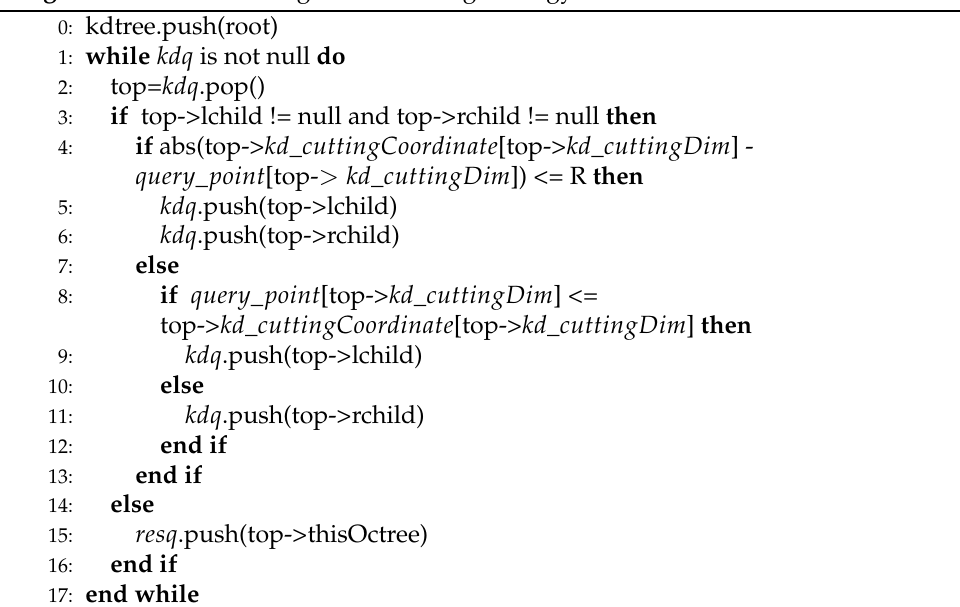
Algorithm 1: Nearest Neighbor Searching